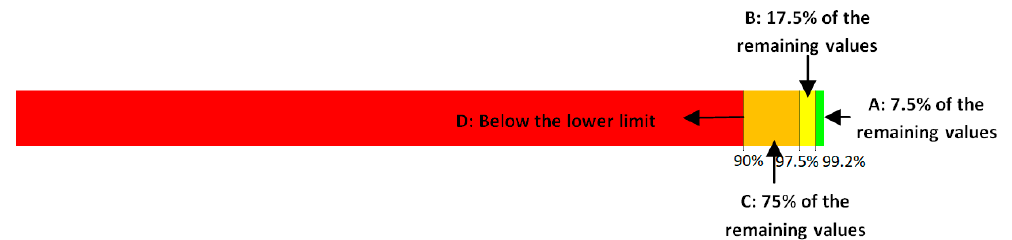
Figure 8. Label limits for indirect tensile strength ratio (ITSR; gap-graded and asphalt concrete friction courses).